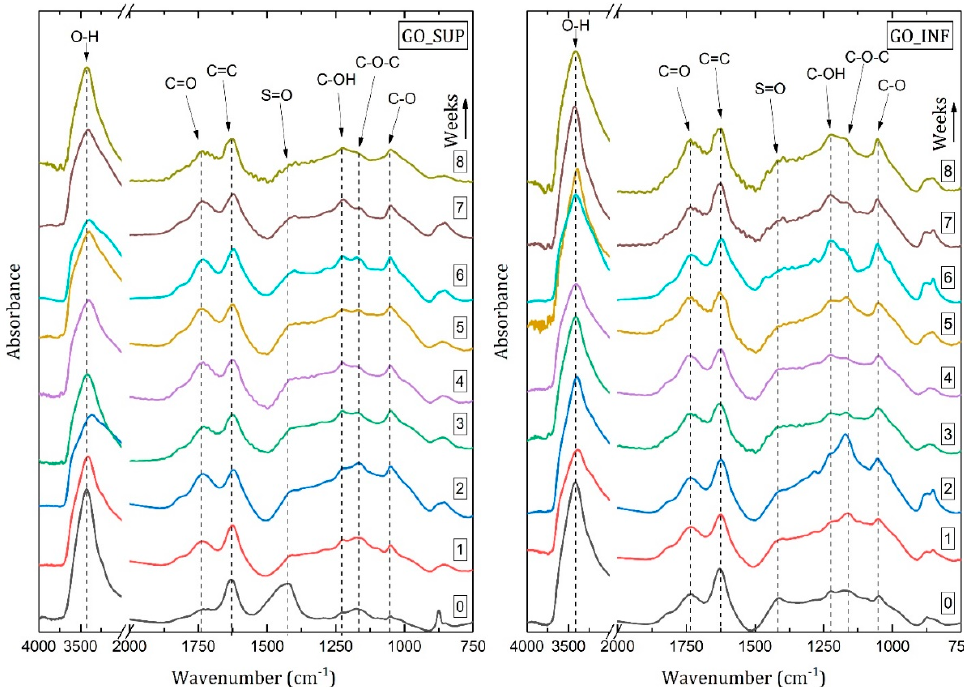
Figure 7. FT − IR spectra recorded weekly over the considered time period for the dried GO_SUP ( left ) and GO_INF ( right ) samples.